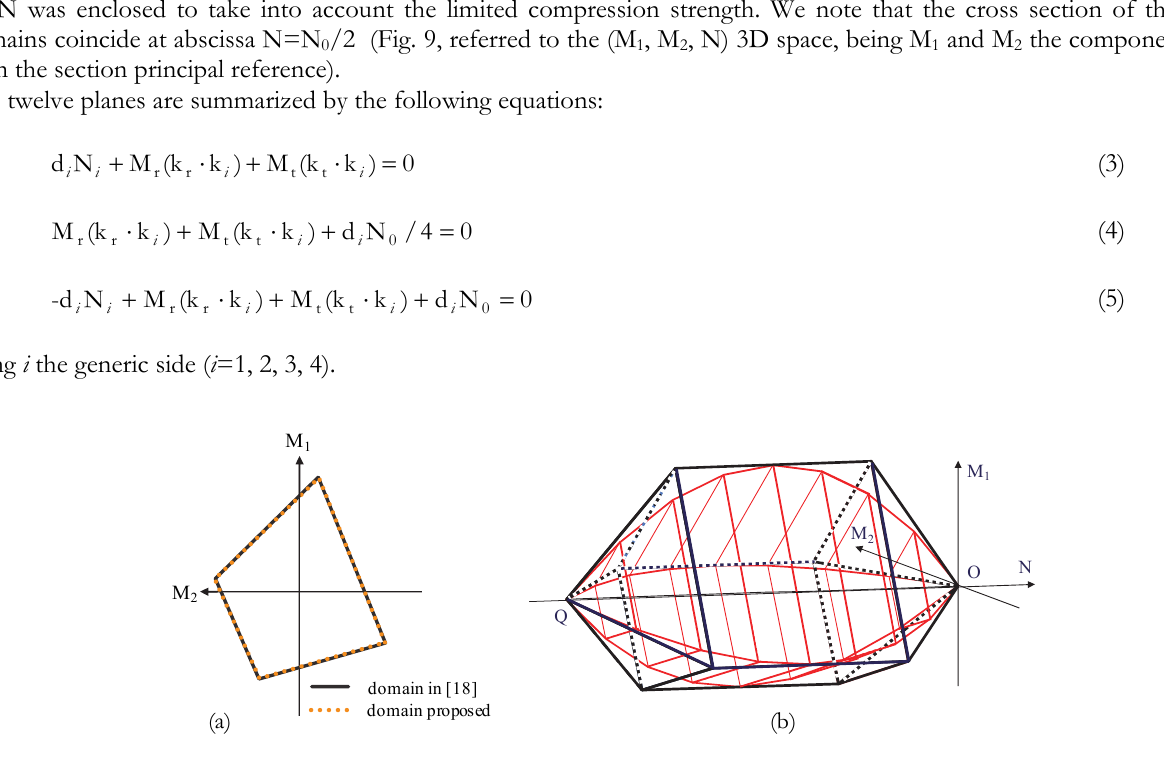
Figure 9: Yield domain for rocking in the 3D space (M 1 , M 2 , N). (a) Cross section at N=N0/2.; (b) 3D view (axonometric projection) of linearized yield domain proposed and the approximate non linear one proposed in [18].